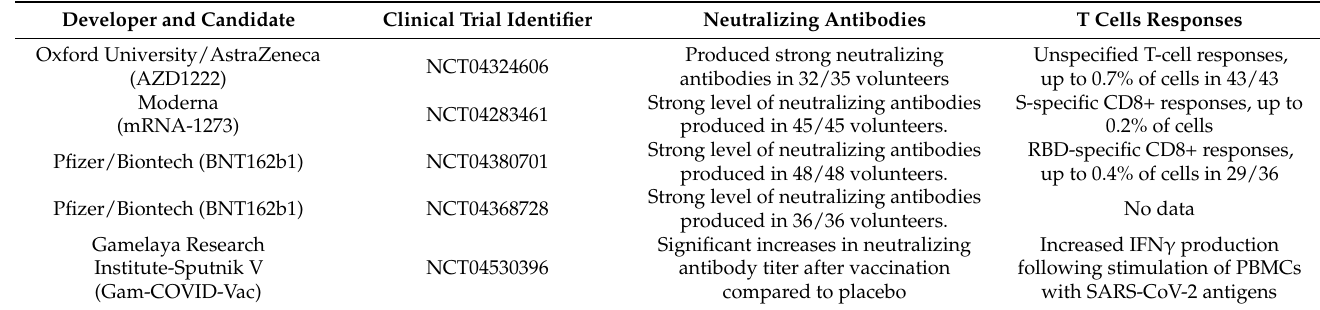
Table 1. Summary of neutralizing antibody and T-cell response for some